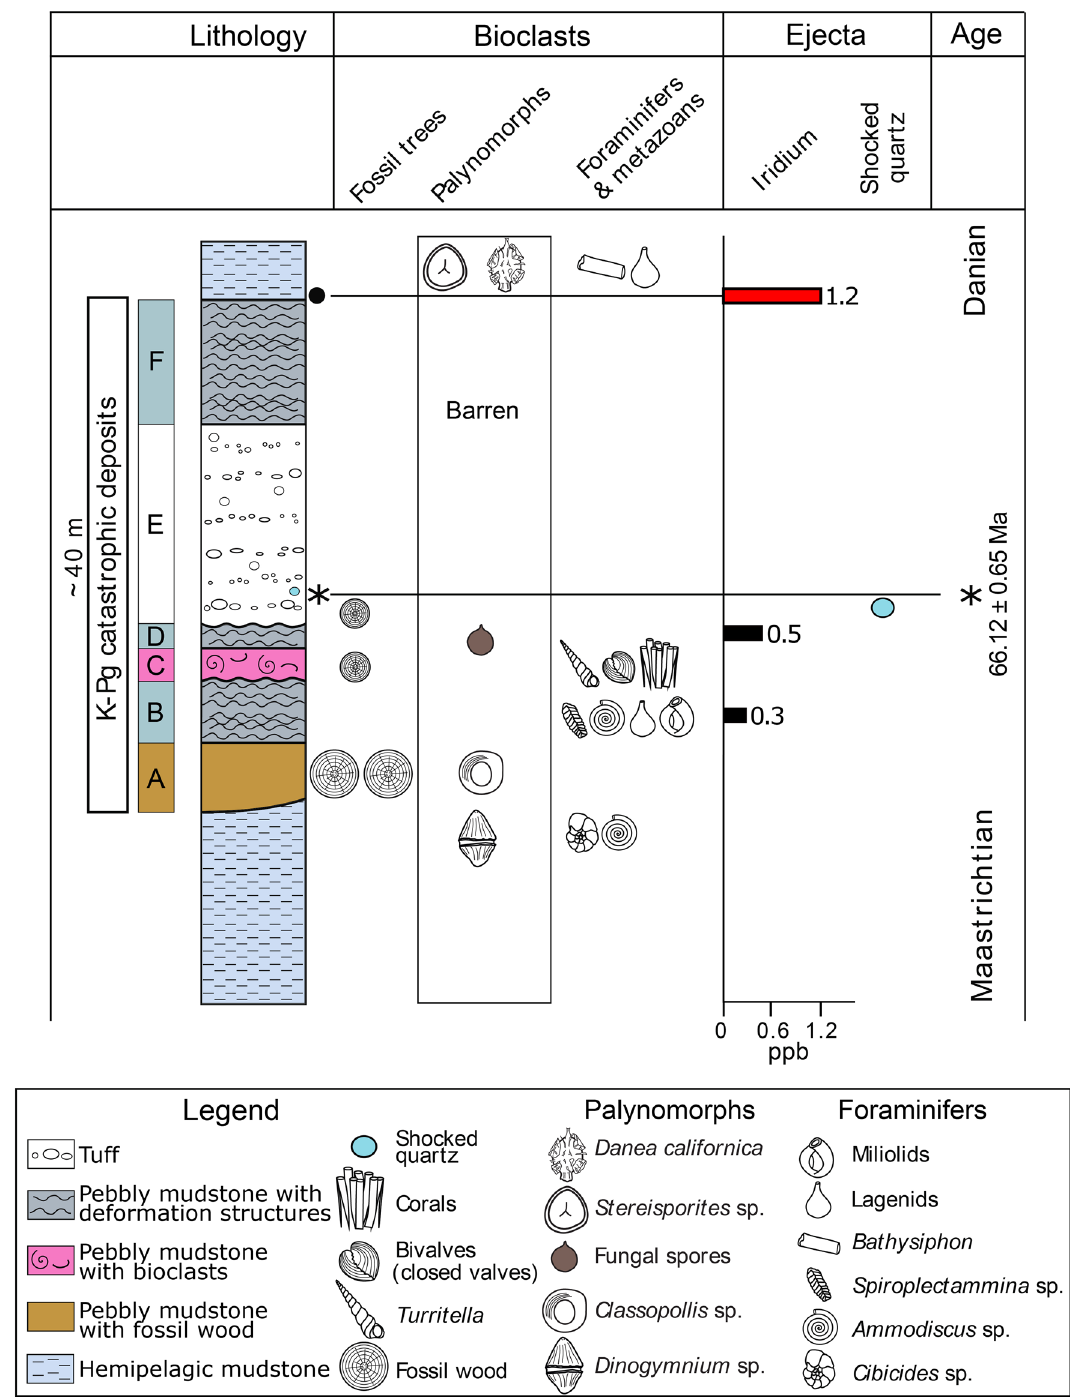
Figure 5. Generalized section of K–Pg catastrophic deposits in this study, showing lithologic units, the occurrence of fossilized tree trunks, occurrences of selected abundant palynomorphs, foraminifers and metazoan taxa, iridium concentrations, shocked quartz crystal occurrence, and absolute